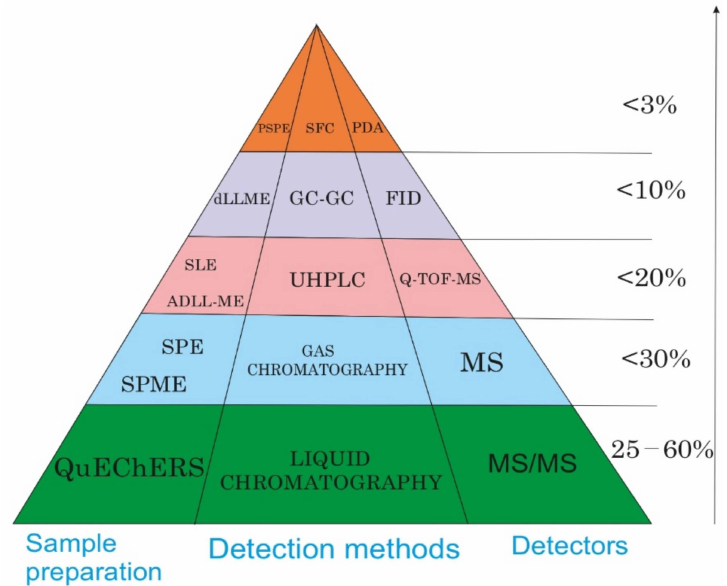
Figure 6. Frequently used analyzers, sample preparation methods, and methods for determining the residual amounts of pesticides in grapes were made based on this review for